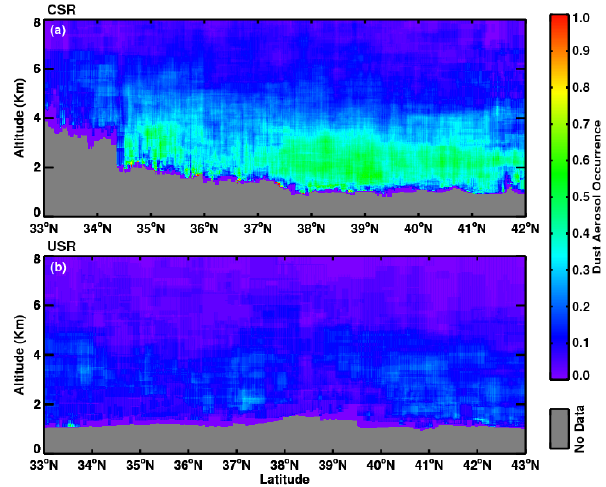
Fig. 4. Vertical structure of dust aerosol occurrence from CALIPSO observations over the (a) CSR and (b) USR in relation to zonal mean regional surface altitude (shown in grey).